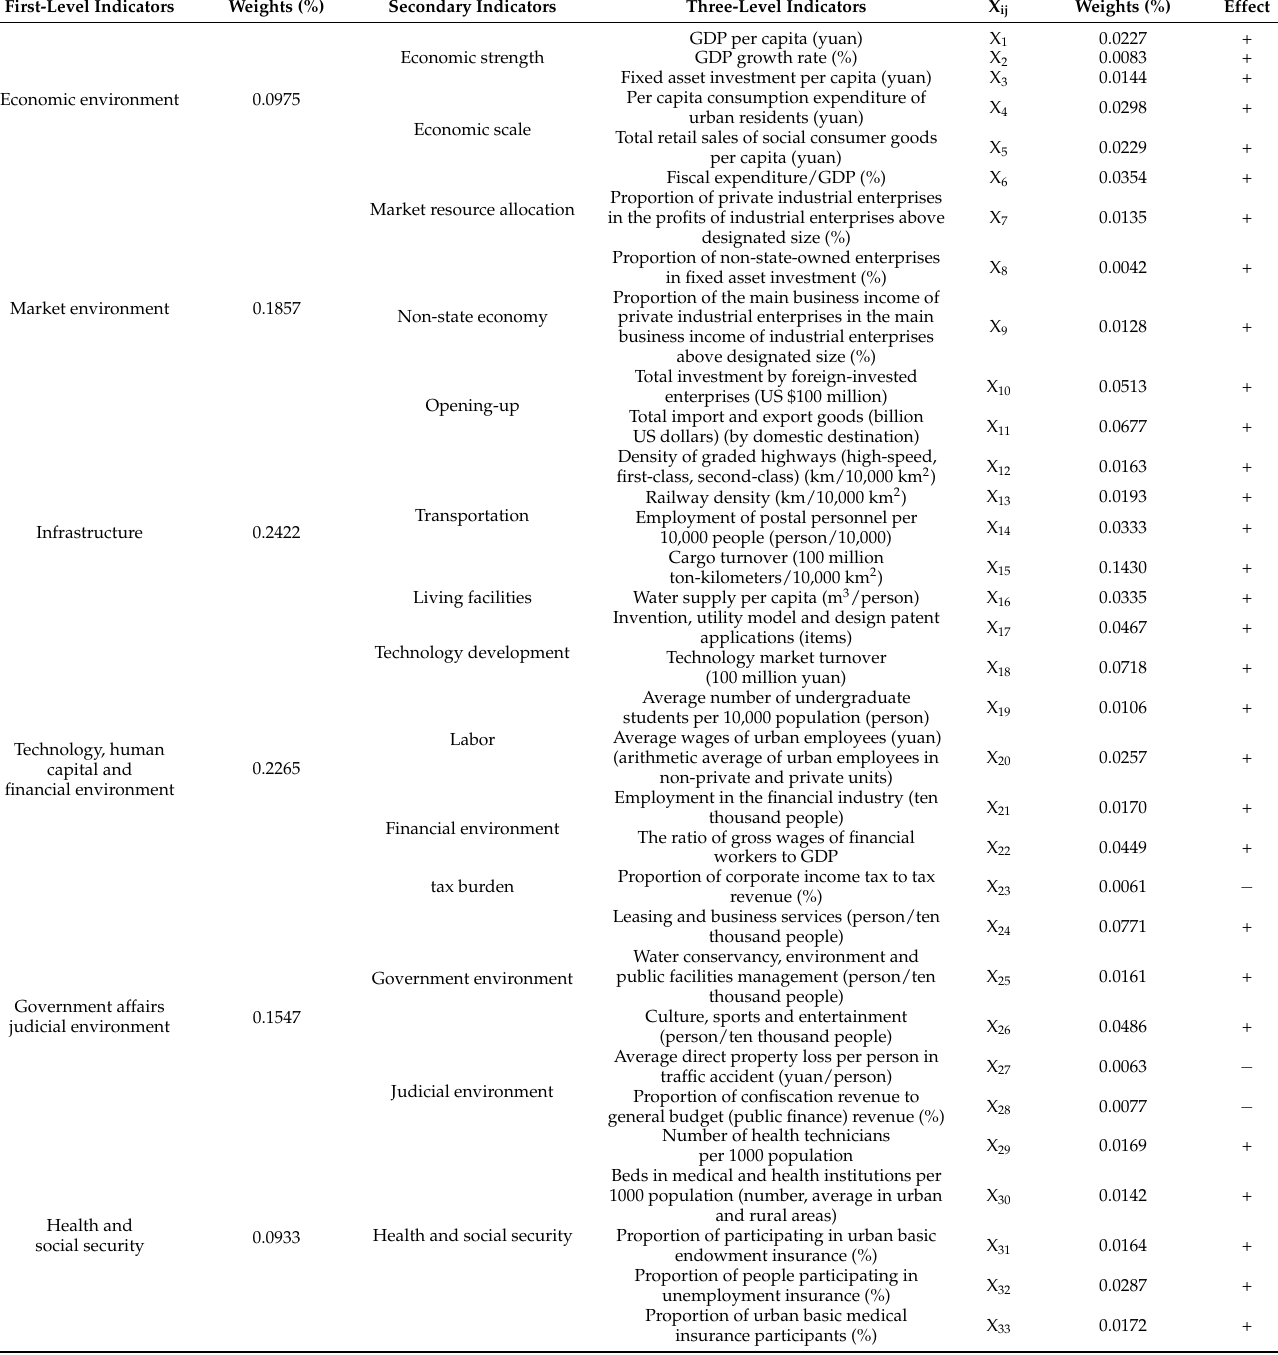
Table 1. Evaluation index system and weight composition of China’s provincial and municipal business